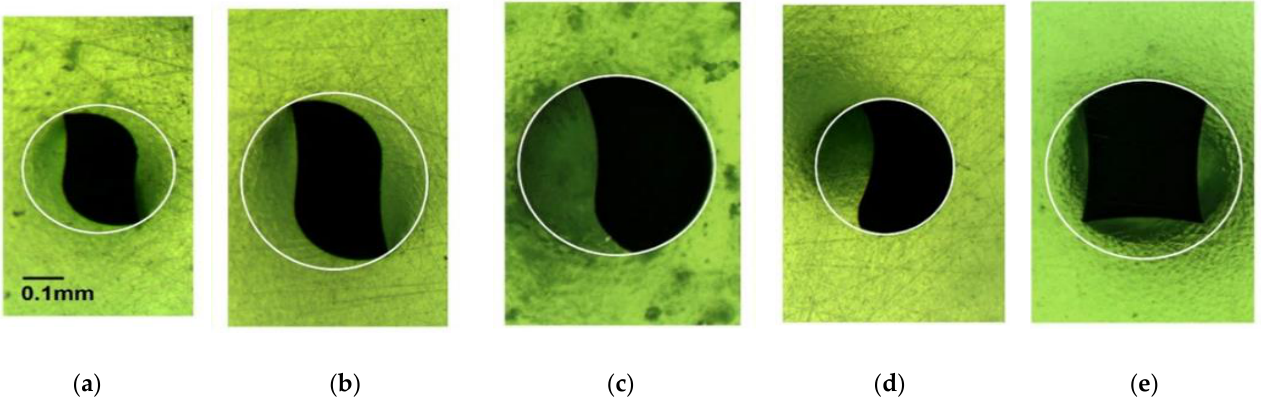
Figure 1. Cross-sectional shape of the instruments (size 25) used in this study at D5.( a ) F360 (Taper .04); and ( b ) F6 SkyTaper (Taper .06): S-shaped; ( c ) Silk-Standard (Taper .06) and ( d ) Complex (Taper .04): Tear drop design with radial lands. ( e ) Jizai (Taper .04): Modified rectangle with radial lands and an offset mass of rotation.